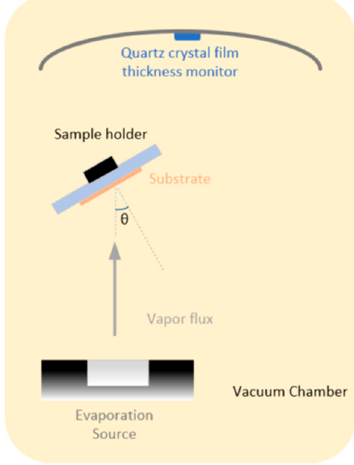
Figure 3. The configuration of OAD system.